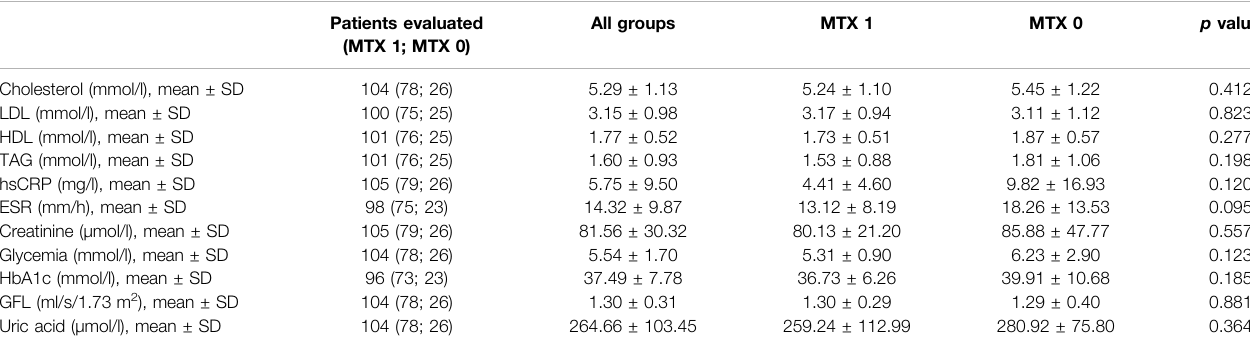
TABLE 2 | Comparison of laboratory test results between groups of RA patients treated (MTX 1 group) or non-treated (MTX 0 group) with MTX. Patients evaluated (MTX 1; MTX